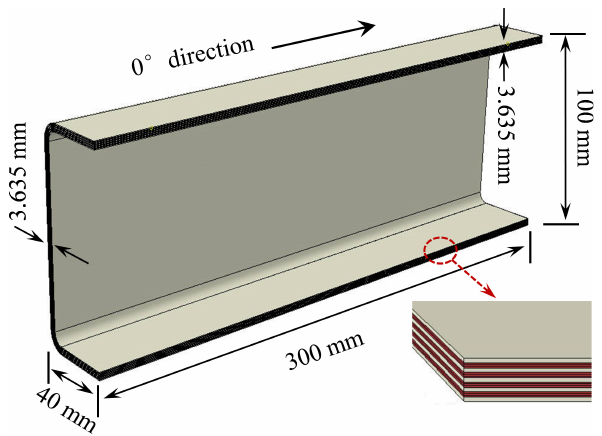
Figure 1: Global dimension and shape of a single-channel cross- sectional compression